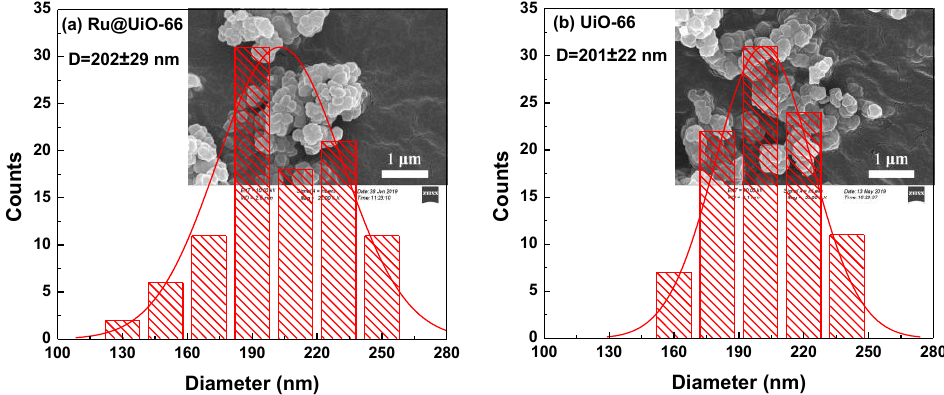
Figure 4. Scanning electron microscopy (SEM) images and the corresponding histograms of the size distribution of ( a ) Ru@UiO-66 and ( b ) UiO-66.